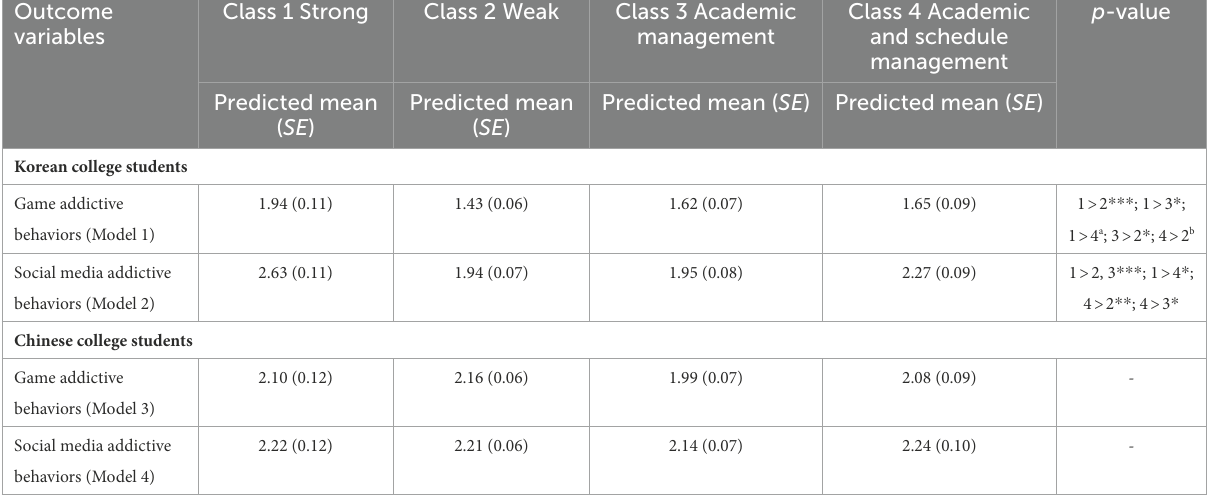
TABLE 5 Results of paired comparison test of game and social media addictive behaviors across four helicopter parenting latent classes in Korean and Chinese college students. Outcome